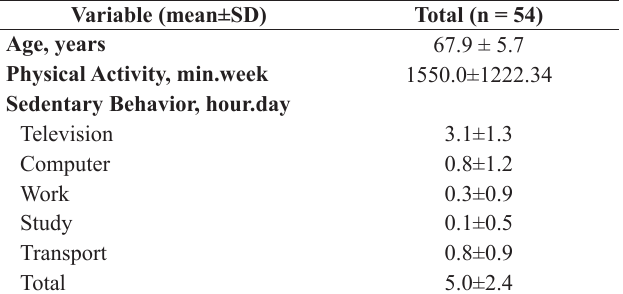
Table 1: General characteristics of the sample (age, physical activity and sedentary behaviour).